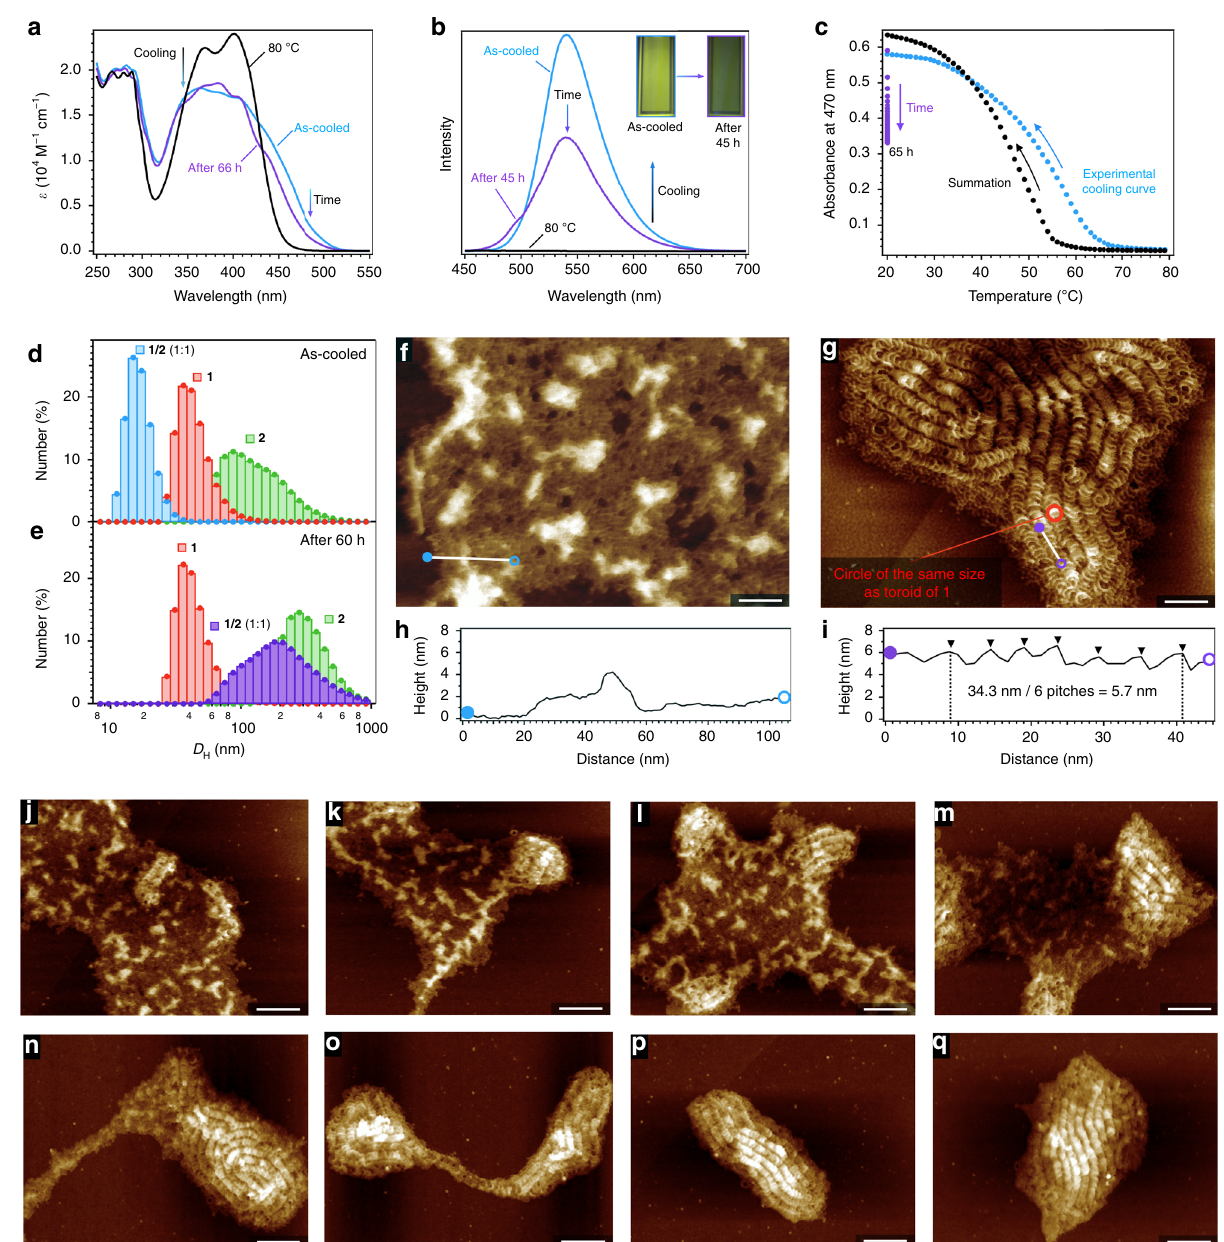
Fig. 2 Supramolecular copolymerization. a , b Absorption ( a ) and fl uorescence emission ( b ) spectra of a 1:1 mixture of 1 and 2 ( c t = 100 µ M) at 80 °C (black lines) and 20 °C (blue lines) upon cooling, and the subsequent time-dependent change after several days at 20 °C (purple lines). Insets in b are photographs of the solution at 20 °C under illumination with UV light. c Plots of the change in the absorbance intensity at 470 nm as a function of temperature upon cooling (blue dots), followed by the time-dependent change (purple dots). The black dots were obtained by simple summation of the separately measured cooling plots of 1 ( c t = 50 µ M) and 2 ( c t = 50 µ M). d , e DLS pro fi les of 1 (red; c t = 100 µ M), 2 (green; c t = 100 µ M), and their 1:1 mixture (blue and purple; c t = 100 µ M) in MCH measured immediately after cooling to 20 °C ( d ) and after aging for 60 h ( e ). f , g AFM images of the amorphous coaggregates ( f aged for 0 h) and helicoids ( g aged for 31 h) formed by a 1:1 mixture of 1 and 2 ( c t = 100 µ M) at 20 °C. h , i Cross-sectional analyses along the white lines in f and g , respectively. Scale bars, 50 nm. j – q AFM images showing the transition of the amorphous coaggregates into helicoids. The samples were spin-coated onto highly oriented pyrolytic graphite (HOPG) substrates and aged for 0.5 h ( j ), 1 h ( k ), 2 h ( l ), 4 h ( m ), 6 h ( n ), 20 h ( o ), 24 h ( p ), and 72 h ( q ). Scale bars, 100